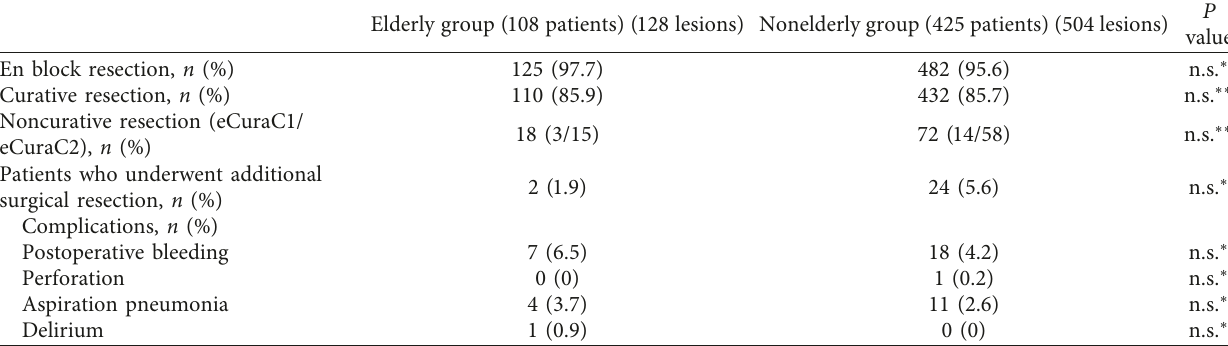
Table 3: Curative resection rates and complications related to endoscopic submucosal dissection.